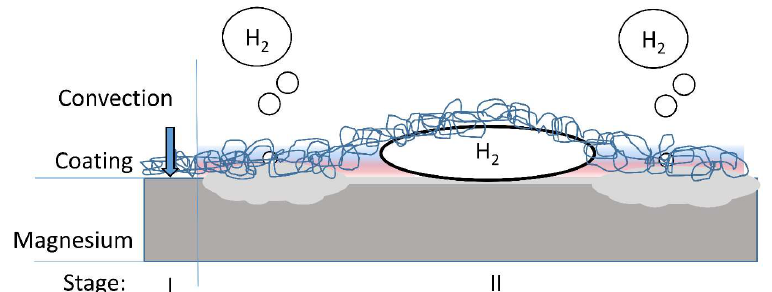
Figure 11. Schematic representation of the interaction of fiber coating with magnesium corrosion. The fluid reaches the magnesium surface (Stage I), and a hydrogen bubble forms due to magnesium reacting with water. The bubble is trapped underneath the coating and hinders water from reaching the surface (Stage II).